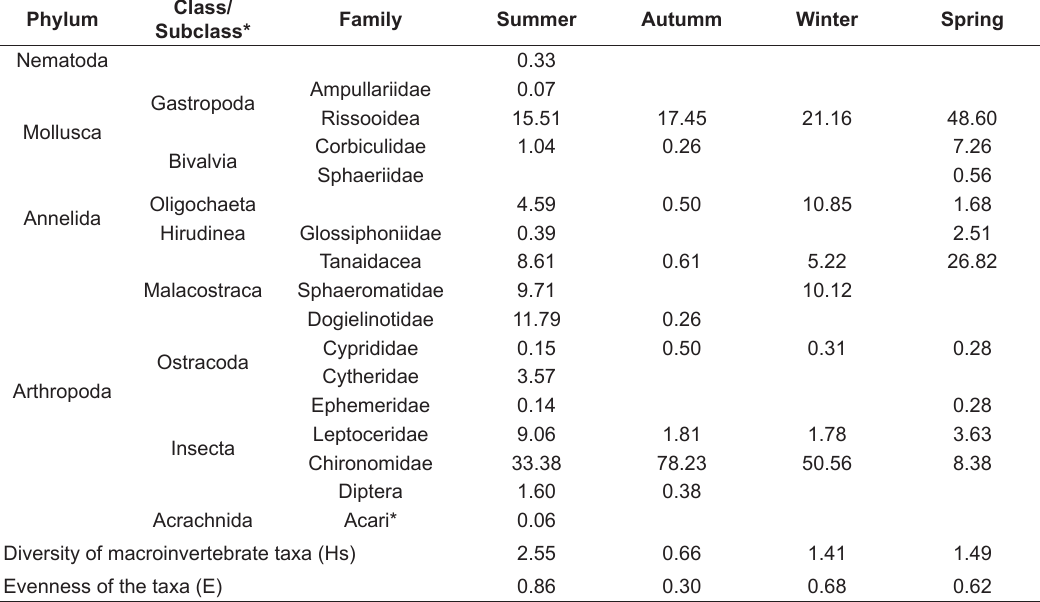
Table 1. Macroinvertebrate taxa of Lake Figueira and their relative abundance (%) during the entire sampling period and diversity of macroinvertebrates (Hs), maximum diversity (Hmax) and Eveness rate (E).